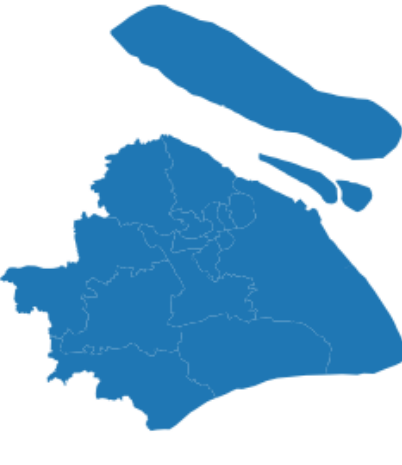
Figure 1: Shapefile of Shanghai urban